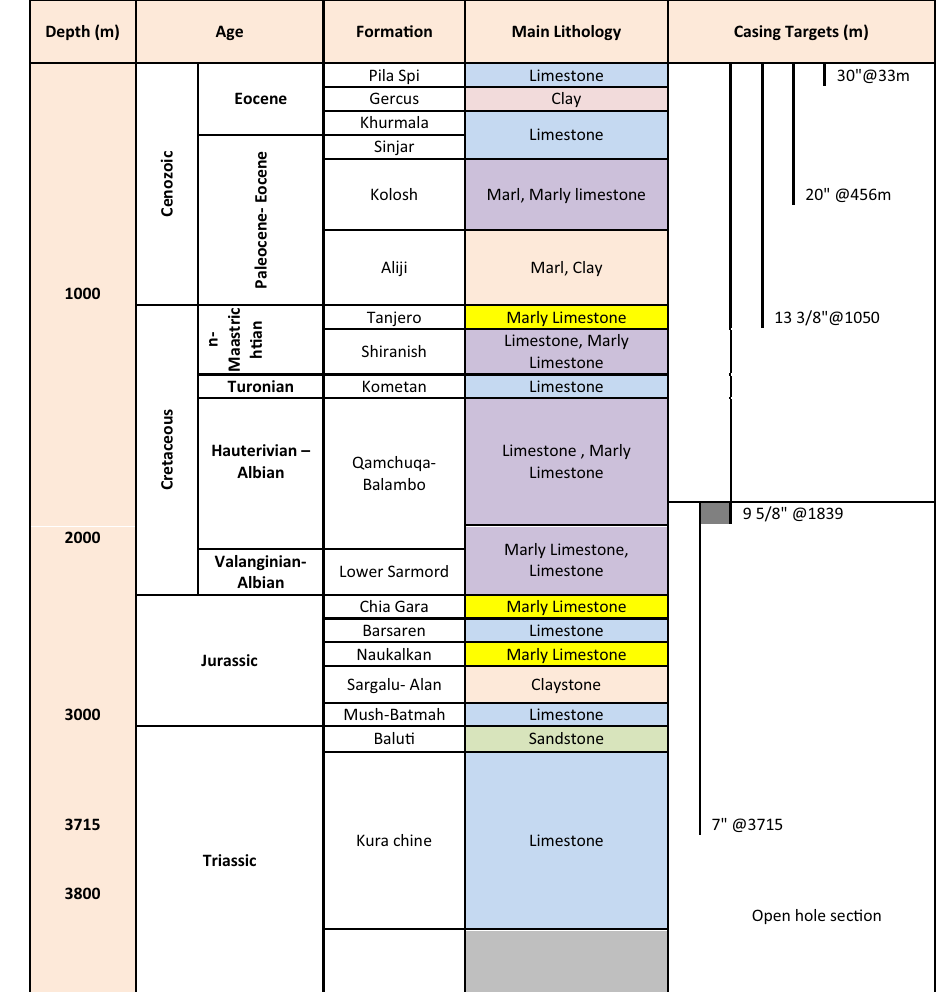
Fig. 3 Geological stratigraphy and formations penetrated in